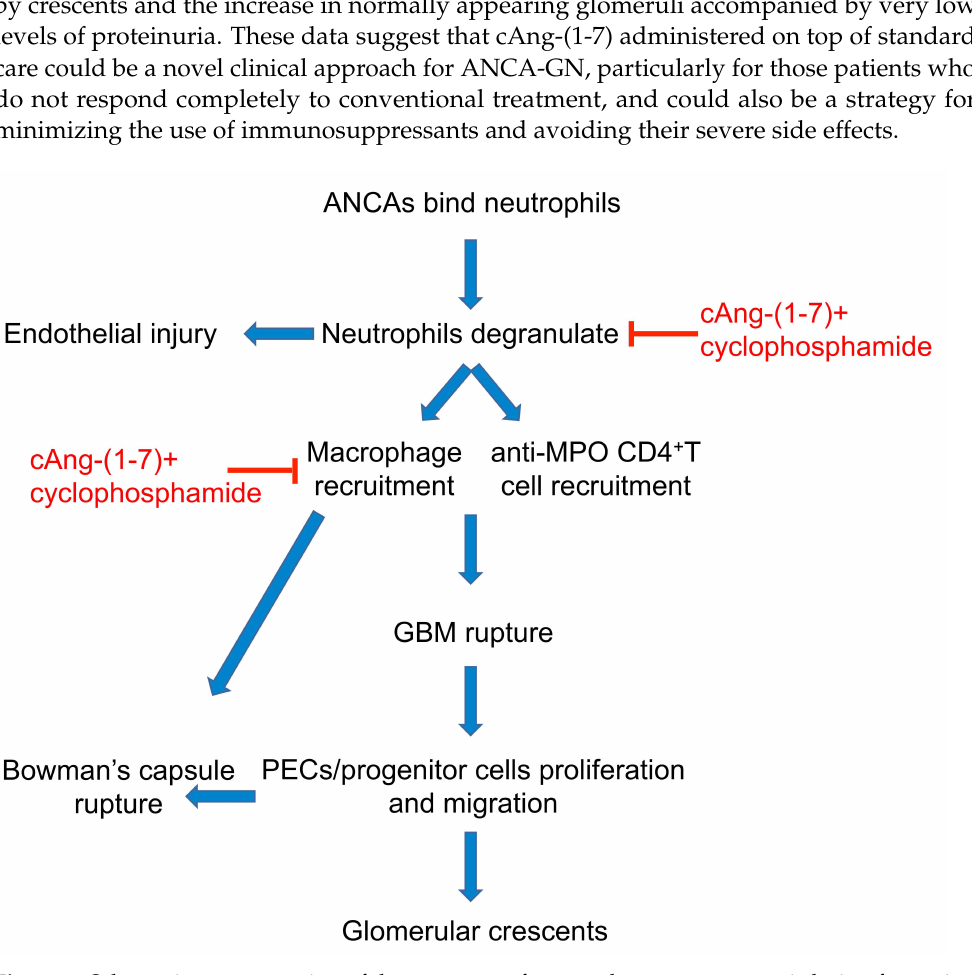
Figure 7. Schematic representation of the sequence of events that cause crescentic lesion formation in WKY rats with MPO-ANCA-glomerulonephritis, and possible targets of cAng-(1-7) + cyclophos- phamide therapy. ANCA, anti-neutrophil cytoplasmic antibodies; MPO, myeloperoxidase; cAng-(1-7), cyclic angiotensin 1-7; GBM, glomerular basement membrane; PECs, parietal epithelial